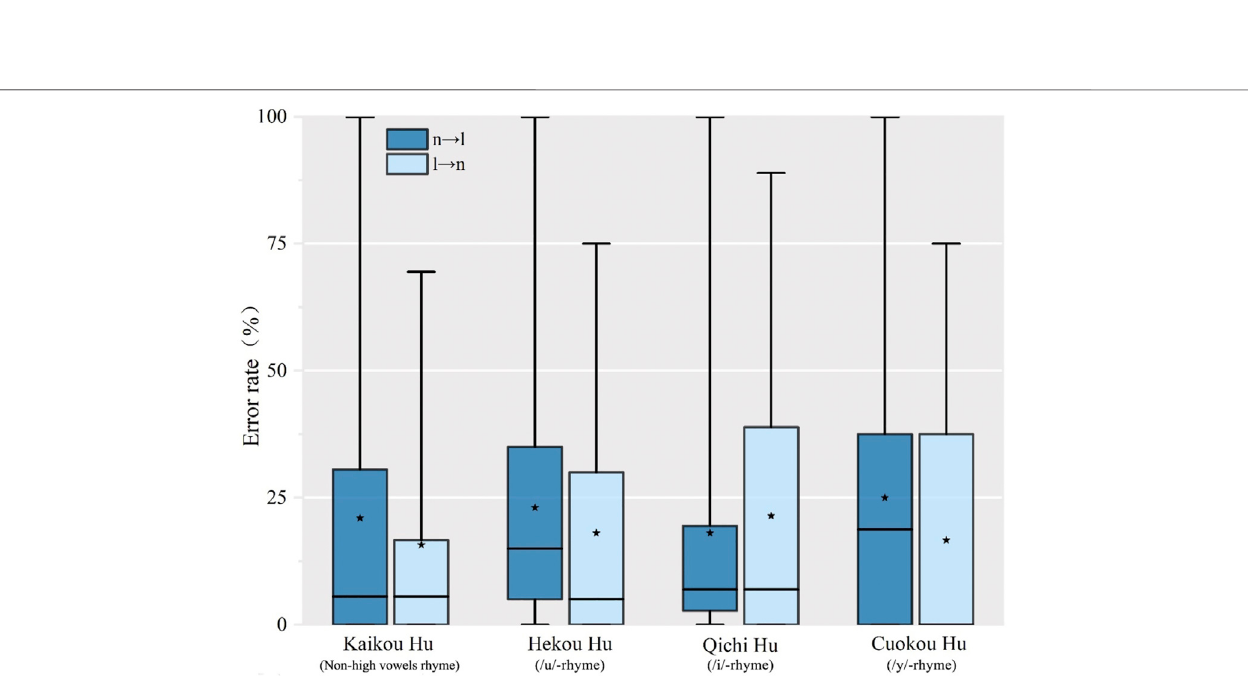
FIGURE 3 | Error rate of production of Standard Mandarin words with initial /n/ and /l/ by word types.